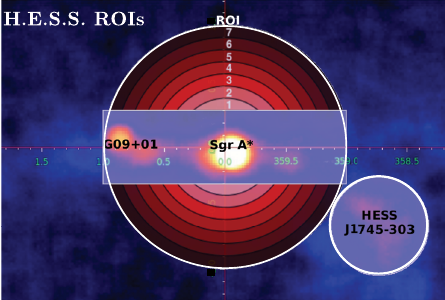
Figure 1. Galactic Center sky map in Galactic longi- tude and latitude. The RoIs are shown in red and the excluded regions as shaded areas. The standard VHE γ - ray sources Sgr A*, G09 + 01 and HESS J1745-303 are